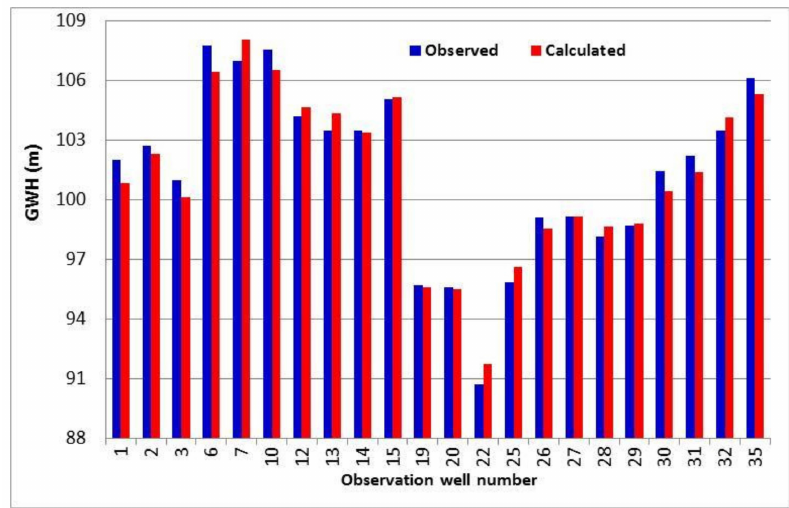
Figure 9. The calculated head by MODFLOW and observed head from field data for year 2020.